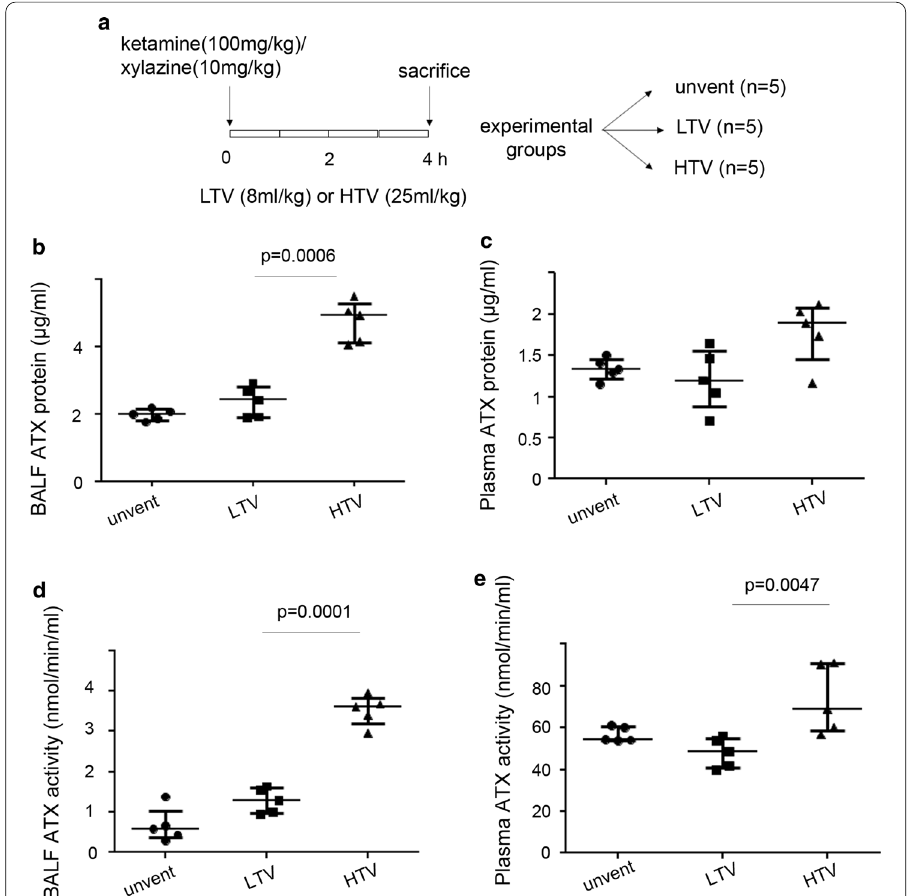
Fig. 1 Increased ATX concentrations in the BALFs and plasma of ventilated mice. a Graphic representation of the experimental groups studied. b BALF ATX concentrations were measured using an ELISA assay. c ATX concentrations in plasma were determined by ELISA. d , e ATX activity in BALFs and in plasma, respectively, was measured using a modified Amplex Red PLD activity kit. n 5 mice per group. Data are expressed as = medians with interquartile range (*statistically significant differences, P < 0.05) LTV low tidal volume, HTV high tidal volume, ATX autotaxin, BALF bronchoalveolar lavage fluid, PLD phospholipase